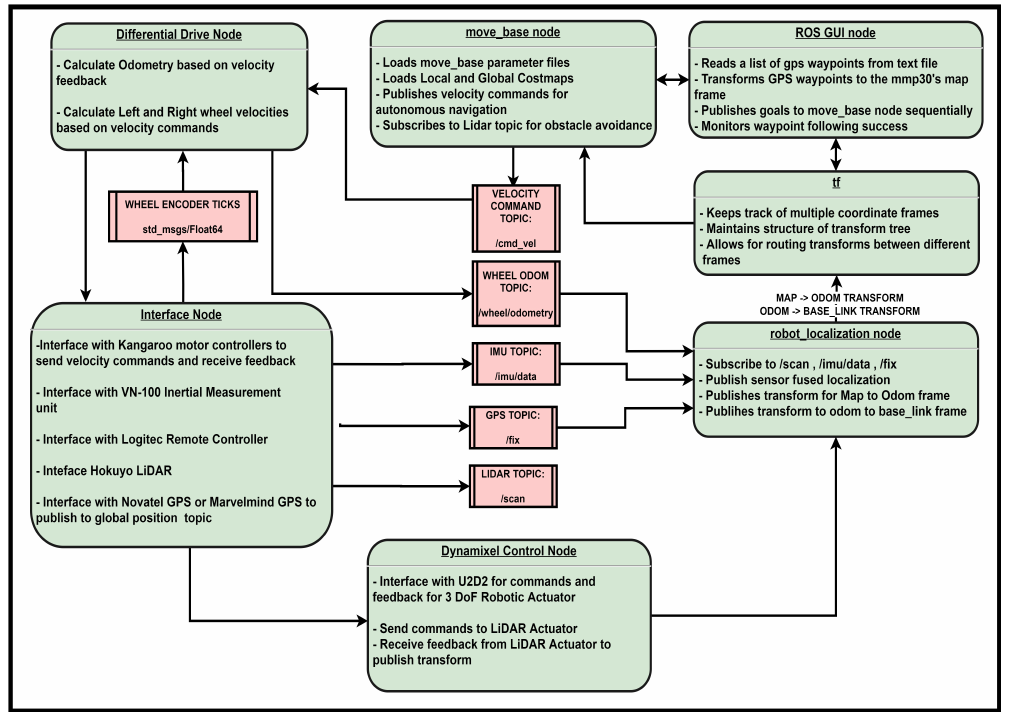
Figure 4. Simplified Robot Operating System (ROS) node